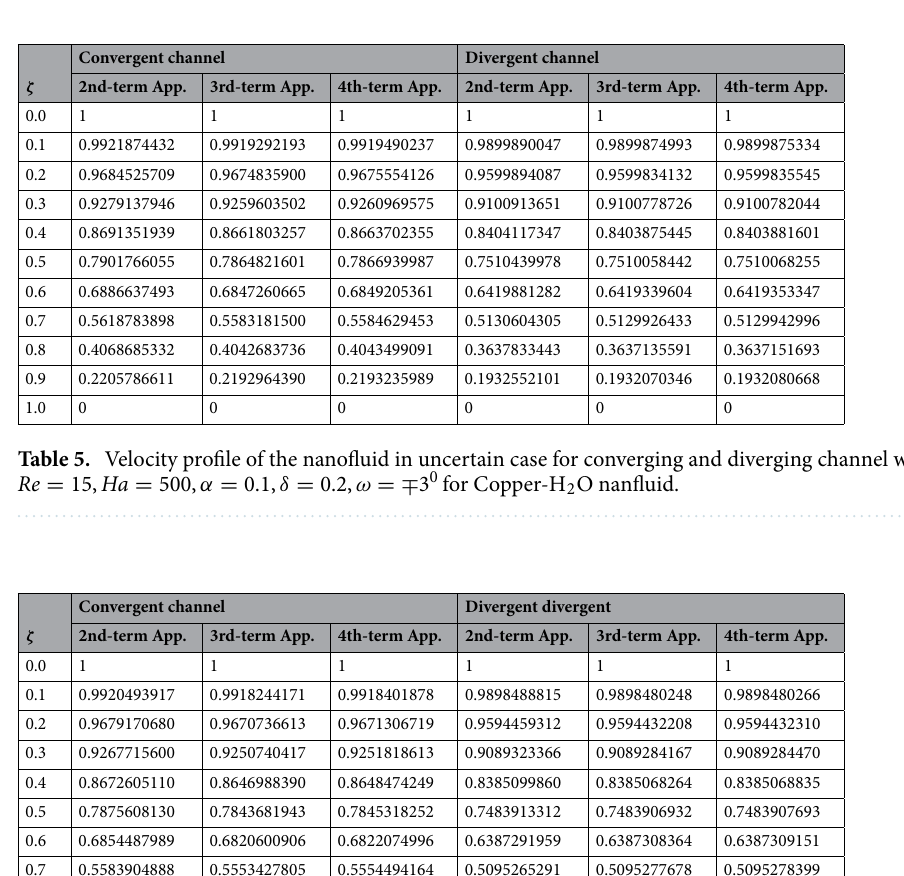
Table 6. Velocity profile of hybrid nanofluid in uncertain case for converging and diverging channel when Re = 15, Ha = 500, α = 0.1, δ = 0.2, ω = ∓ 3 0 for Cu-Al 2 O 3 /H 2 O nanfluid.